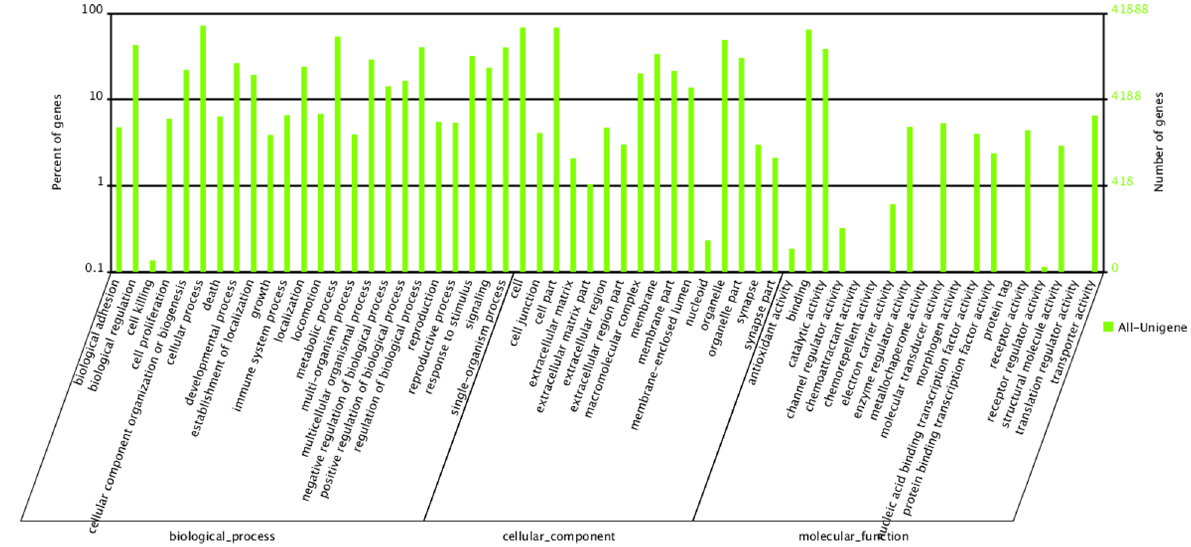
Figure 2. Histogram presentation of Gene Ontology (GO) classification. The results are divided into three GO categories: biological processes, cellular components, and molecular functions.